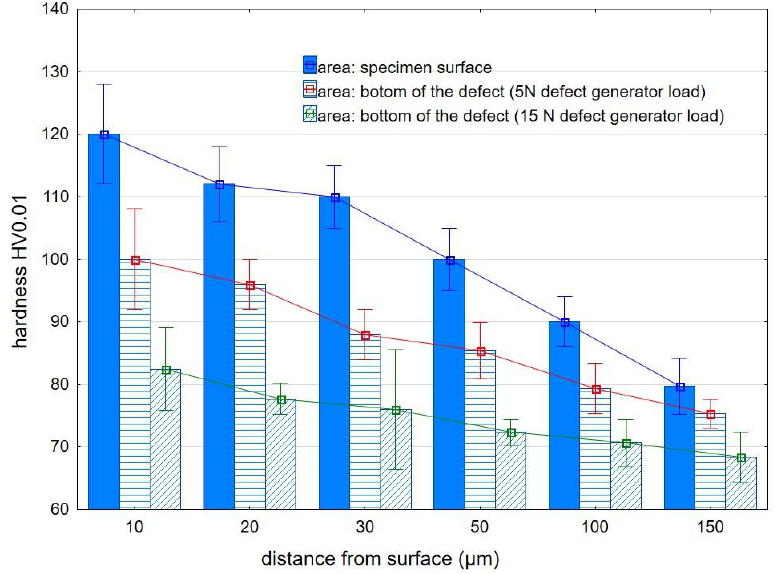
Figure 13. Microhardness distribution of AZ91 HP magnesium alloy after brushing.